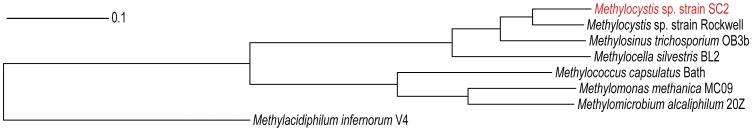
Neighbor-joining tree constructed for the methanotrophic core genome.The tree is based on the alignment of 154 CDS that are common to all eight methanotroph genomes used for comparative analysis. Non-matching parts of the alignments were eliminated prior to tree construction. The individual gene alignments were combined into one concatenated alignment. The neighbor-joining tree was constructed using EDGAR. All branches of the phylogenetic tree showed 100% bootstrap support based on 500 replications. See ‘Materials and Methods’ for further details.